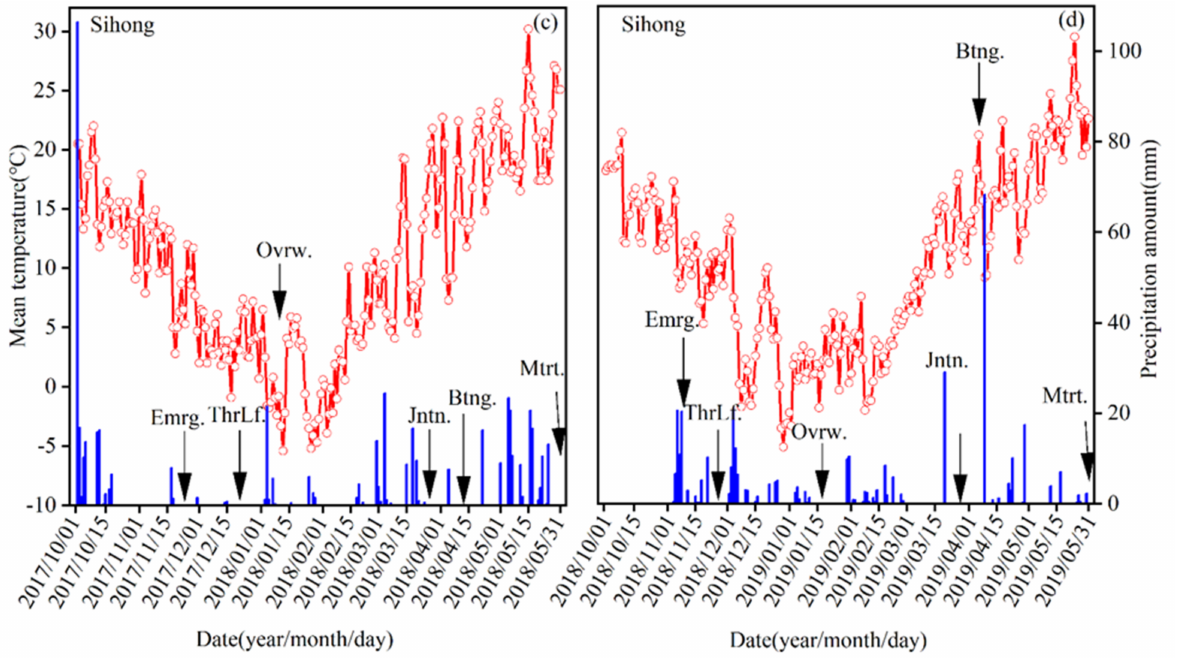
Figure 2. Daily mean temperature and precipitation amount at the experimental sites of Jintan ( a , b ) and Sihong ( c , d ) during the wheat growing seasons of 2017–2018 ( a , c ) and 2018–2019 ( b , d ). Emrg.: seedling emergence, ThrLf.: three-leaf stage, Ovrw.: overwintering stage, Jntn.: jointing stage, Btng.: booting stage, Mtrt.: maturity